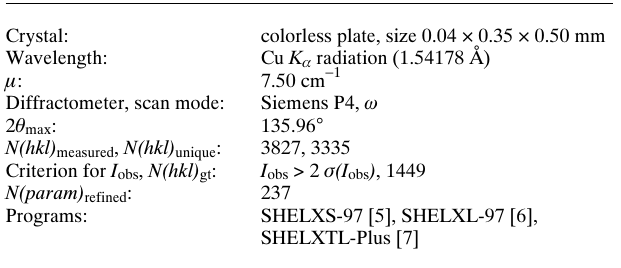
Table 1. Datacollection and